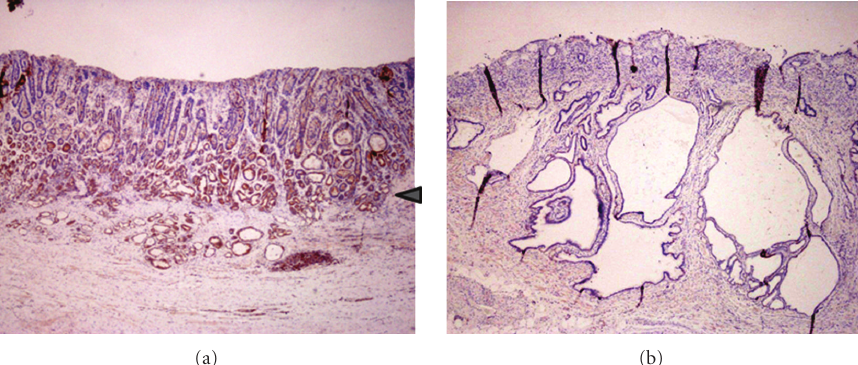
Figure 4: Immunohistochemical staining of BIN1 in a resected specimen of primary advanced gastric cancer. (a) BIN1-positive (arrowhead) and (b) BIN1-negative